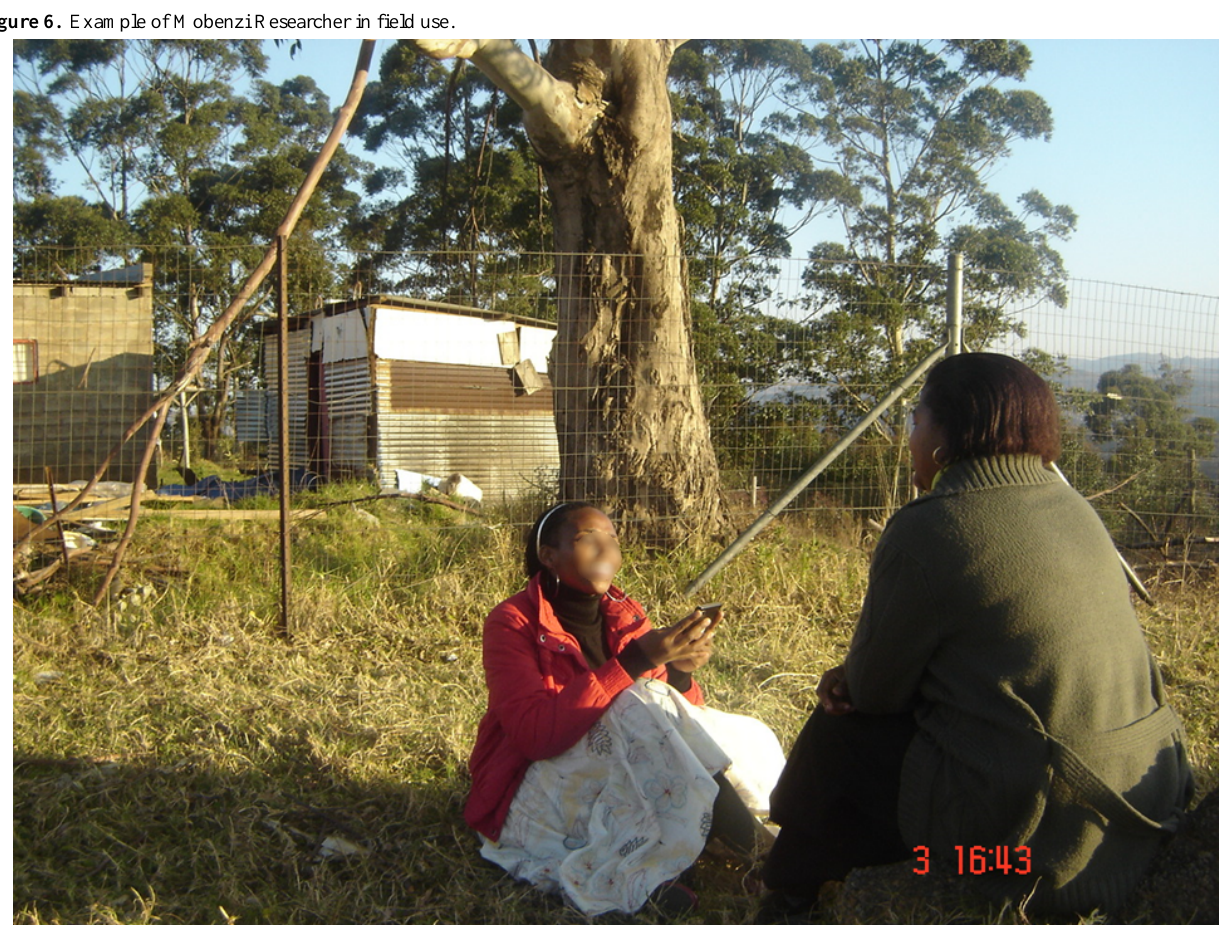
Figure 6. Example of Mobenzi Researcher in field